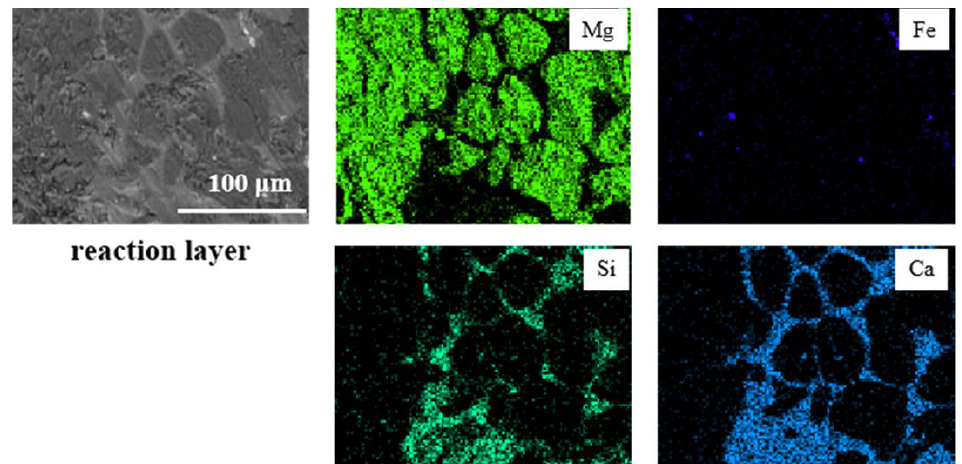
Figure 5. Microstructure and element mapping of the reaction layer in the slag line MgO-C bricks.